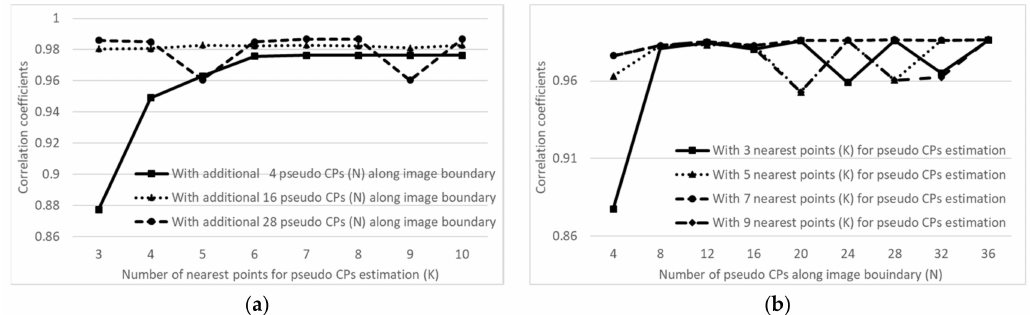
Figure 4. Sensitivity analysis for improved piecewise linear (IPL) transformation parameters: Warping accuracy while changing ( a ) the number of the nearest points for pseudo-conjugate points (pseudo-CP) extraction ( K ) and ( b ) the number of pseudo-CPs along the image boundary ( N